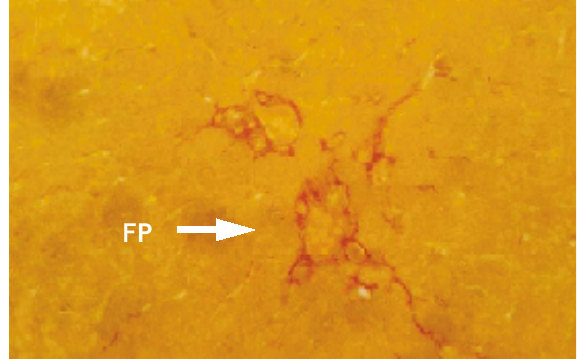
FIGURA 10 – Fotografia apresentando o preparado histológico do grupo 3 (ligados – LDB tratados com quercetina 48h) com coloração Picrosírius, 200x. (FP= fibrose periporta).